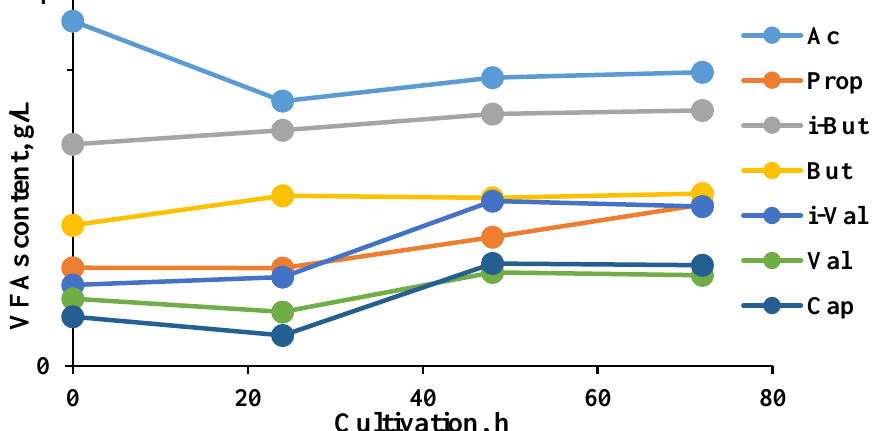
Figure 6. Profile of the volatile fatty acids (VFA) during the hydrogen generation process. Designa- tions: Ac, acetate; Prop, propionate; i-But, isobutyrate; But, butyrate; i-Val, isovalerate; Val, valerate; Cap, capric acid.